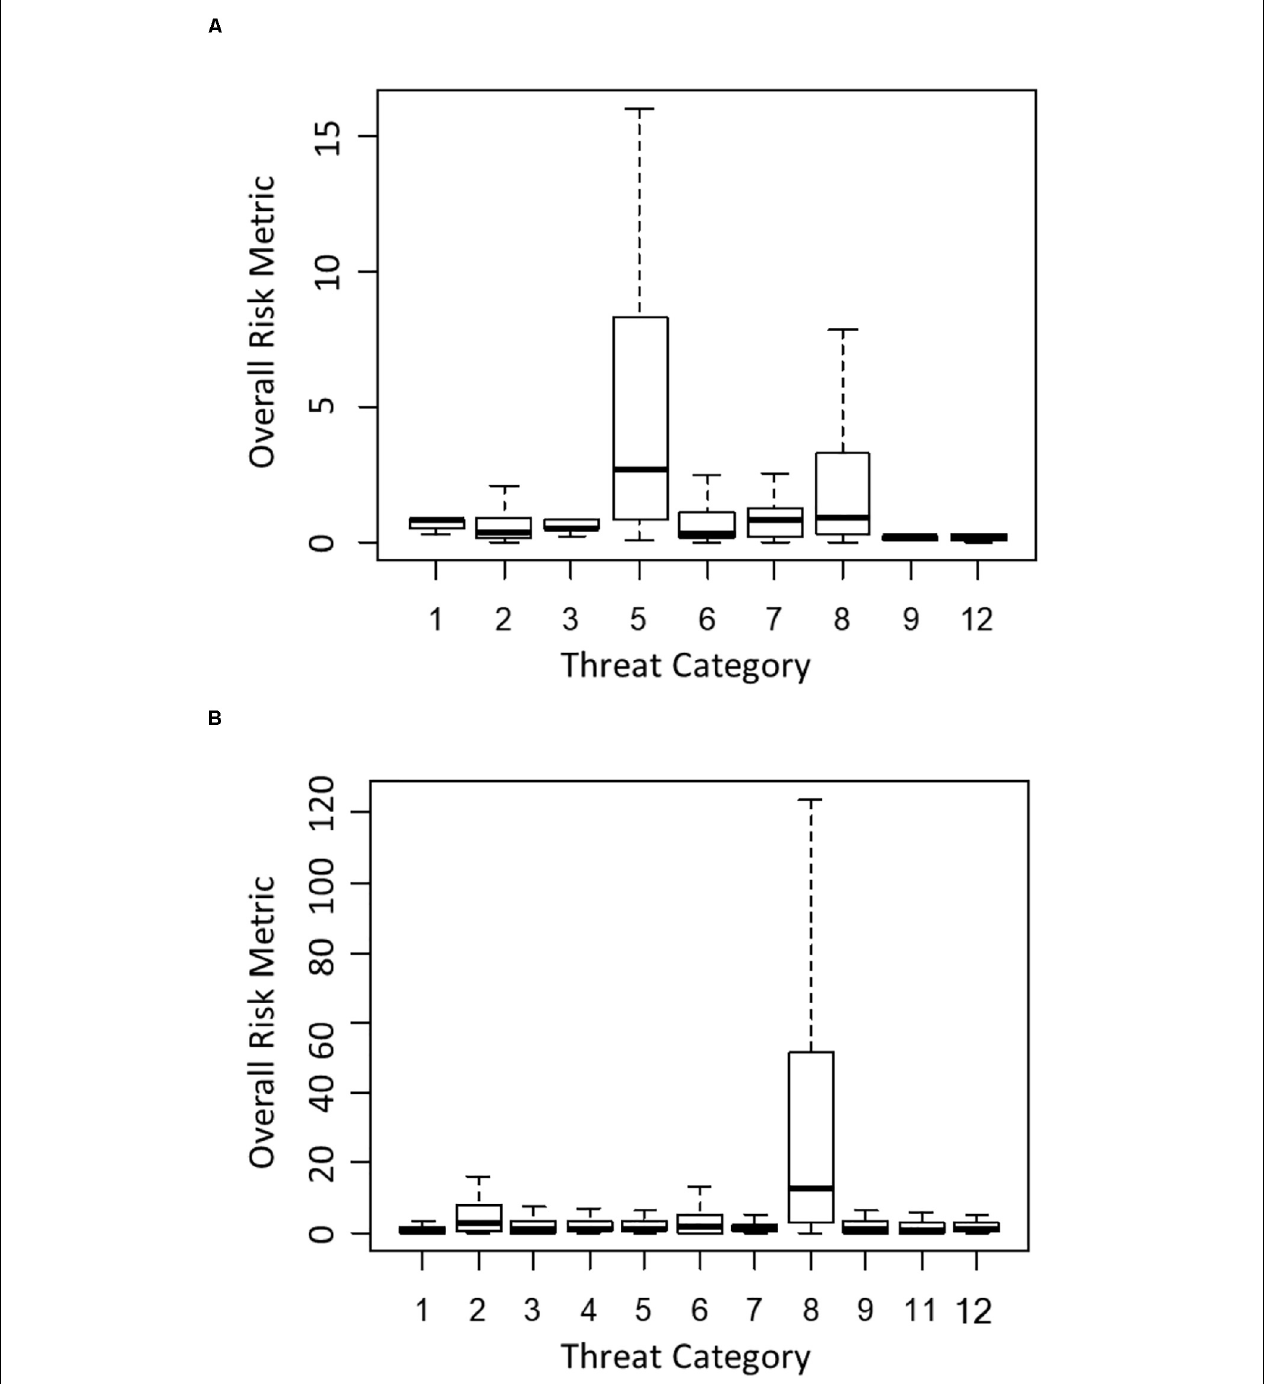
FIGURE 3 | Overall risk metrics [i.e., (100 - % probability of success × cost)] of conservation actions addressing each threat category, for (A) New Zealand and (B) New South Wales. Metrics are presented in units of 1 million, but are not directly comparable between New Zealand and New South Wales, due to currency differences. Threat categories are as for Figure 1 (see Table 1A and Supplementary Table S1 for details).